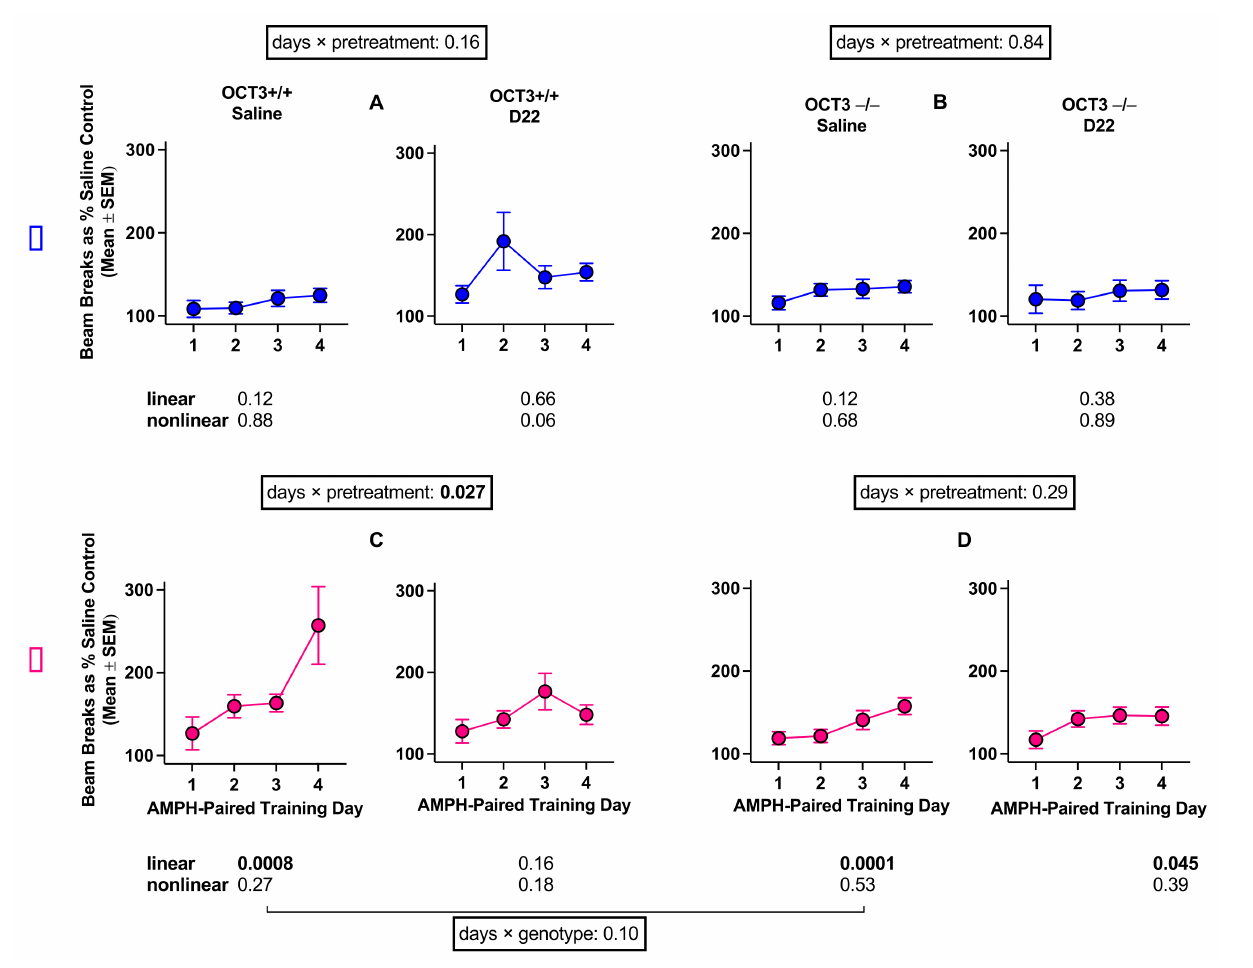
Figure 3. Sensitization to the locomotor stimulating effects of amphetamine (AMPH) in male ( A , B ) and female ( C , D ) organic cation transporter 3 (OCT3) wild-type (+/+) and OCT3 knockout ( − / − ) mice treated with saline or decynium 22 (D22) before amphetamine. Each part of the figure ( A – D ) shows the p value for the days by pretreatment interaction for each genotype and each sex. In addition, a p value is shown for the comparison of genotypes in saline-pretreated females. Additionally, each of the 8 panels (n = 16 mice per panel) shows p values for linear and nonlinear trends across days. Statistically significant p values are shown in